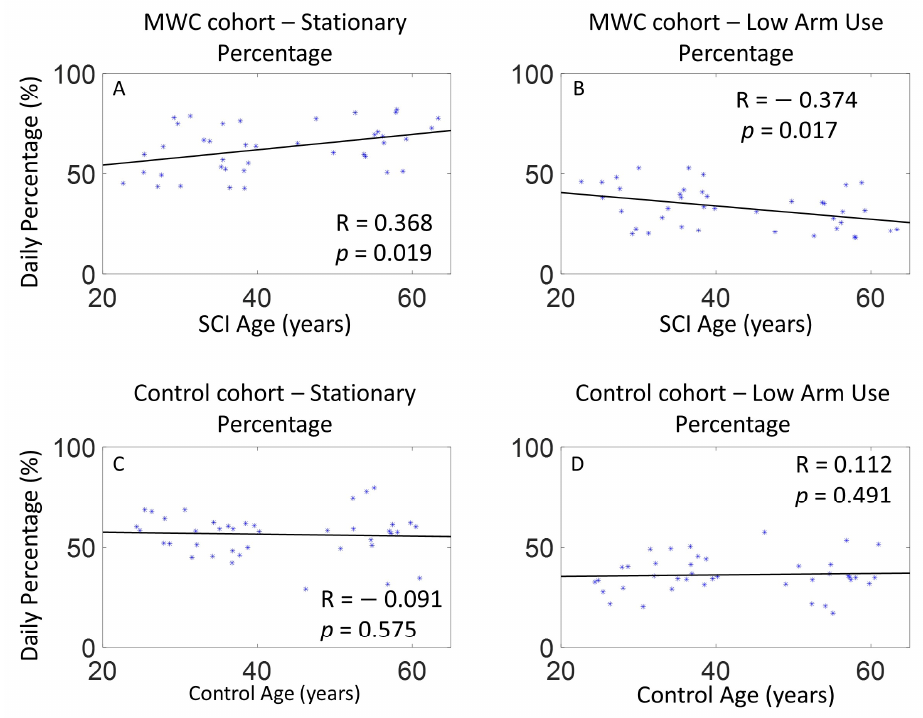
Figure 4. The effect of age on the percentage of daily time spent stationary and in the low arm use intensity levels for the MWC and control cohorts on the dominant arm: ( A ) MWC stationary, ( B ) MWC low arm use intensity level, ( C ) control stationary, ( D ) control low arm use intensity